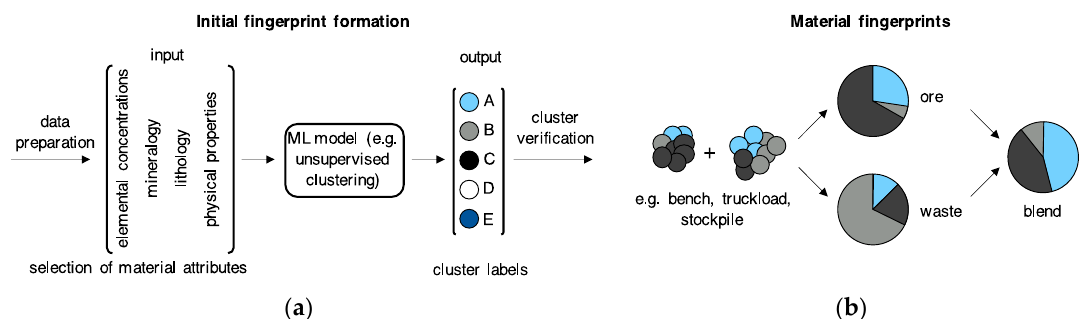
Figure 3. ( a ) An example where initial fingerprint formation is done through unsupervised clustering. Clustering generates potential cluster or class labels and may act as training data input for another machine learning (ML) model which can characterise new fingerprints from measured material attributes; ( b ) An example where three (A, B, C) class outputs are used to explain proportionality of classes. The proportionality of classes allows the formation of fingerprints which characterise ore, waste, or blend types.